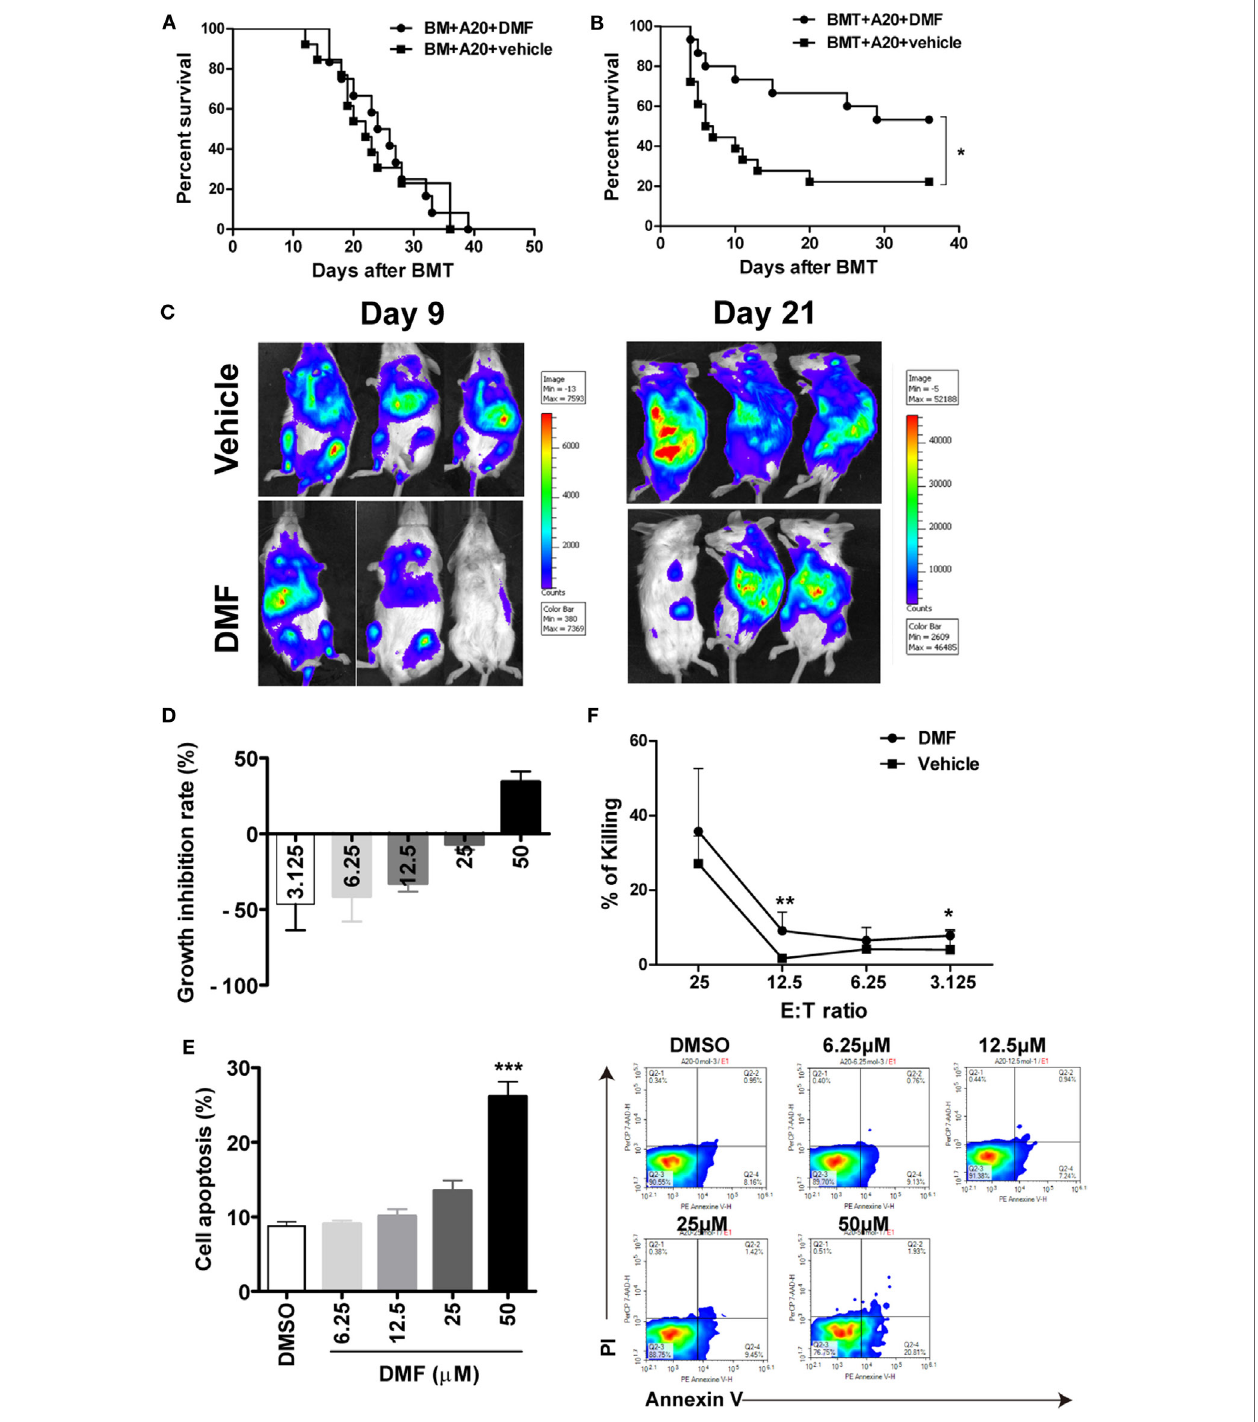
FigUre 5 | Dimethyl fumarate (DMF) administration preserves GVL effect after bone marrow transplantation (BMT). Mice were transplated with BM or BM and spleen plus A20-luc to establish GVL model. Mice transplanted with allo-BM alone plus A20-luc leukemia cells all died from leukemia regardless of whether DMF was administered (a) . DMF administration to mice receiving allo-BMT plus A20-luc showed prolonged survival time and reduced tumor burden compared with mice receiving vehicle control (B,c) . The effects of DMF on A20 cell proliferation (D) and apoptosis (e) were examined by CCK-8 assay and Annexin V/PI staining. Splenocytes from transplanted recipients 14 days after BMT were used as killing cells, and their killing ability of A20 targets was measured using CytoTox 96 nonradioactive cytotoxicity assay kit (F) . Survival data were analyzed by log-rank test and Kaplan–Meier survival curves were generated using GraphPad Prism. Data shown are mean ± SD. * P < 0.05; ** P < 0.01, compared with DMSO group (ANOVA with Dunnett’s test) or vehicle group (Student’s t